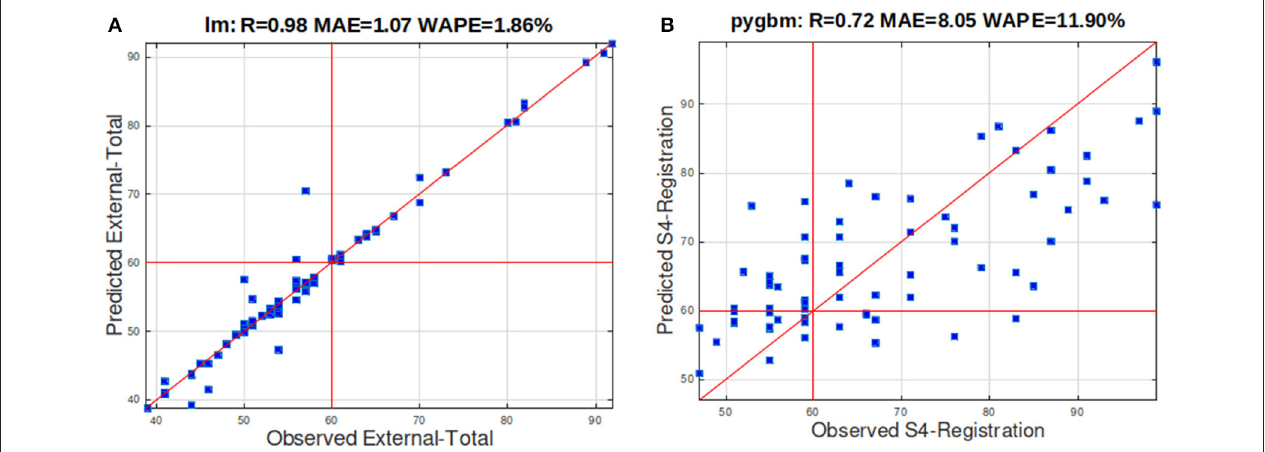
FIGURE 1 | (A) Scatterplot of the true values and values predicted by lm (linear regression) for the externalization domain. (B) Scatterplot of the true values and values predicted by pygbm for social problems (S4). The R , MAE, and WAPE values are reported in the title.